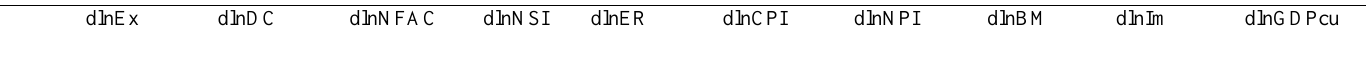
Table 8: Pairwise correlations matrix for Wealth Maximization with NFA covariate (significant variables with less than 90% correlation reported)